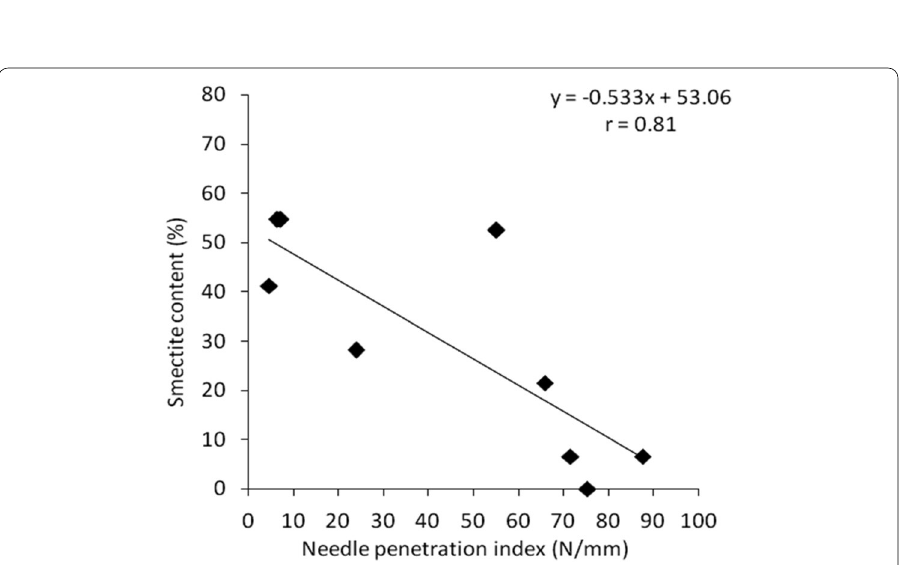
Fig. 9 Correlation between the NPI and smectite